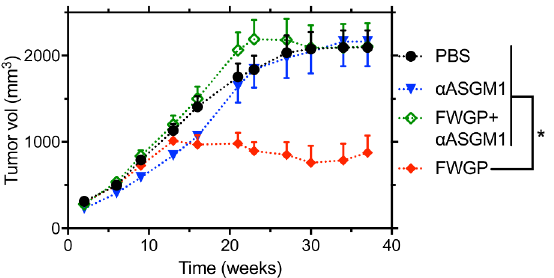
Fig 4. FWGP efficacydepends on NK cell activity in vivo . nu/nu mice bearingestablished Raji tumors were treated with FWGP (140 mg/kg) with or without the NK-cell depletingantibodyanti-ASGM1. Controls receivedeither PBS or the antibody only. Data points represent averagetumor volume ± SEM (n = 8 animals/ group, * p < 0.05,ANOVA with Holm-Sidak multiplecomparison).